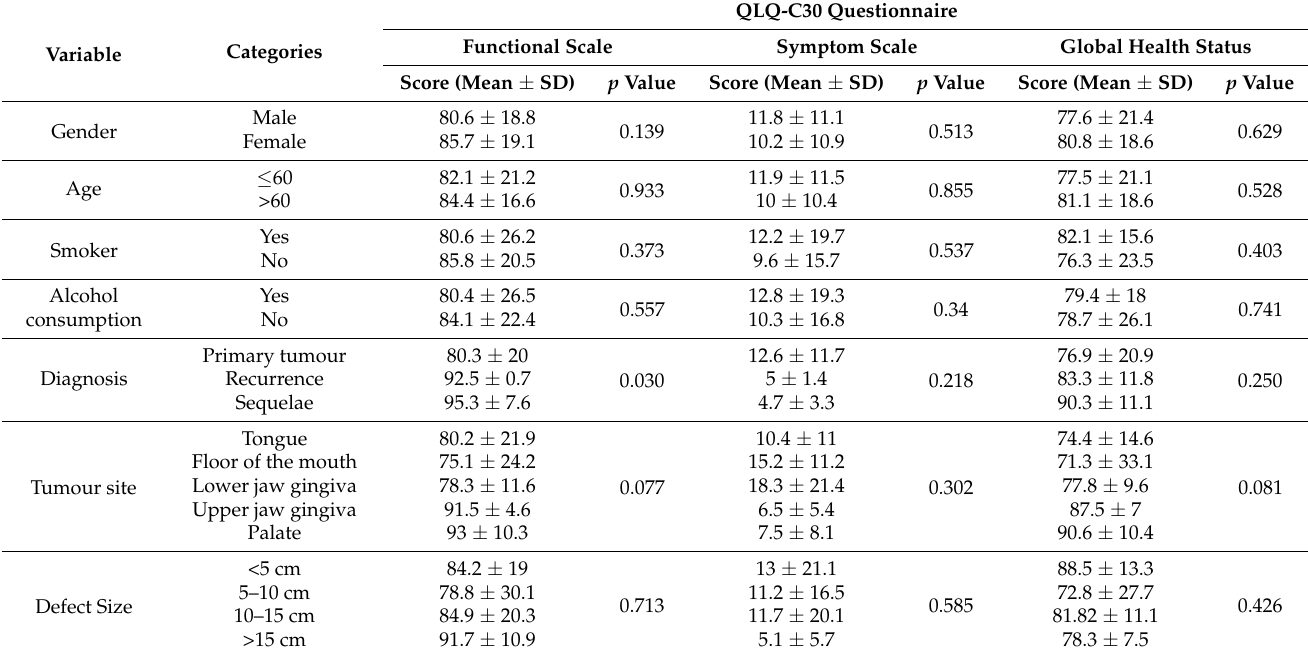
Table 4. Comparison of groups of the QLQ-C30